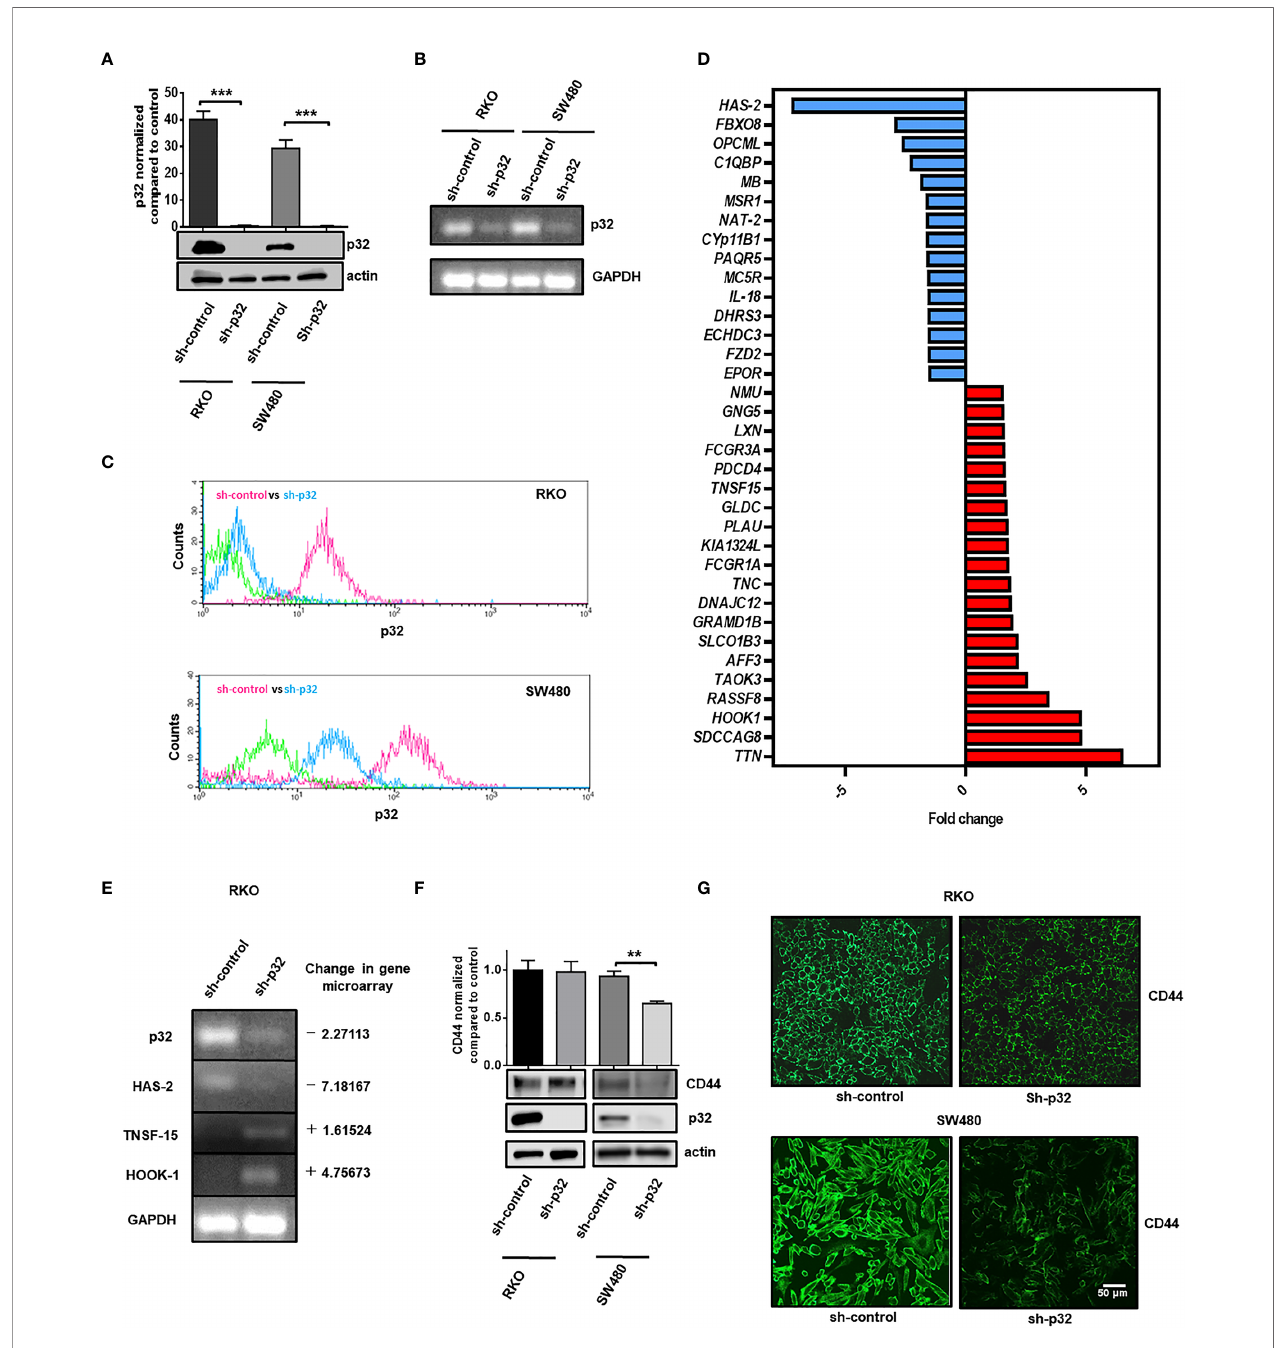
FIGURE 2 | Knockdown of p32 induces changes in the expression levels of proteins related to the malignant phenotype in RKO and SW480 cells. (A) The ef fi ciency of p32 knockdown was evaluated in RKO and SW480 cells by Western blot. Actin was used as a control for equal loading. Densitometric analysis was performed to quantify the change in p32 expression levels. The data is presented as the mean values ± SEM from at least three independent experiments, ***p < 0.001. Knockdown ef fi ciency was also examined by RT-PCR (B) and fl ow cytometry (C) . (D) Fold change of expression graphic of genes related to the malignant phenotype that were downregulated (blue) or upregulated (red) in RKO sh-p32 cells with respect to RKO sh-control. The fold change values were determined from the gene microarray analysis developed as described in the “ material and methods ” section. (E) Changes in the levels of primary transcripts of C1QBP (p32), HAS-2 , TNSF-15 , and HOOK-1 were evaluated by RT-PCR from total RNA extracted from RKO sh-control and RKO sh-p32 cells. (F) The expression level of CD44 was evaluated in RKO and SW480 sh-control and sh-p32 cells by Western blot. p32 levels were also evaluated for each condition to verify knockdown ef fi ciency. Actin was used as a control for equal loading. Densitometric analysis was performed to quantify the change in CD44 expression levels. The data is presented as the mean values ± SEM from at least three independent experiments, **p < 0.01. (G) CD44 expression in RKO and SW480 control and knockdown of p32 cells was also evaluated by immuno fl uorescence microscopy. Representative images from 3 independent experiments are shown. Scale-bar, 50 m